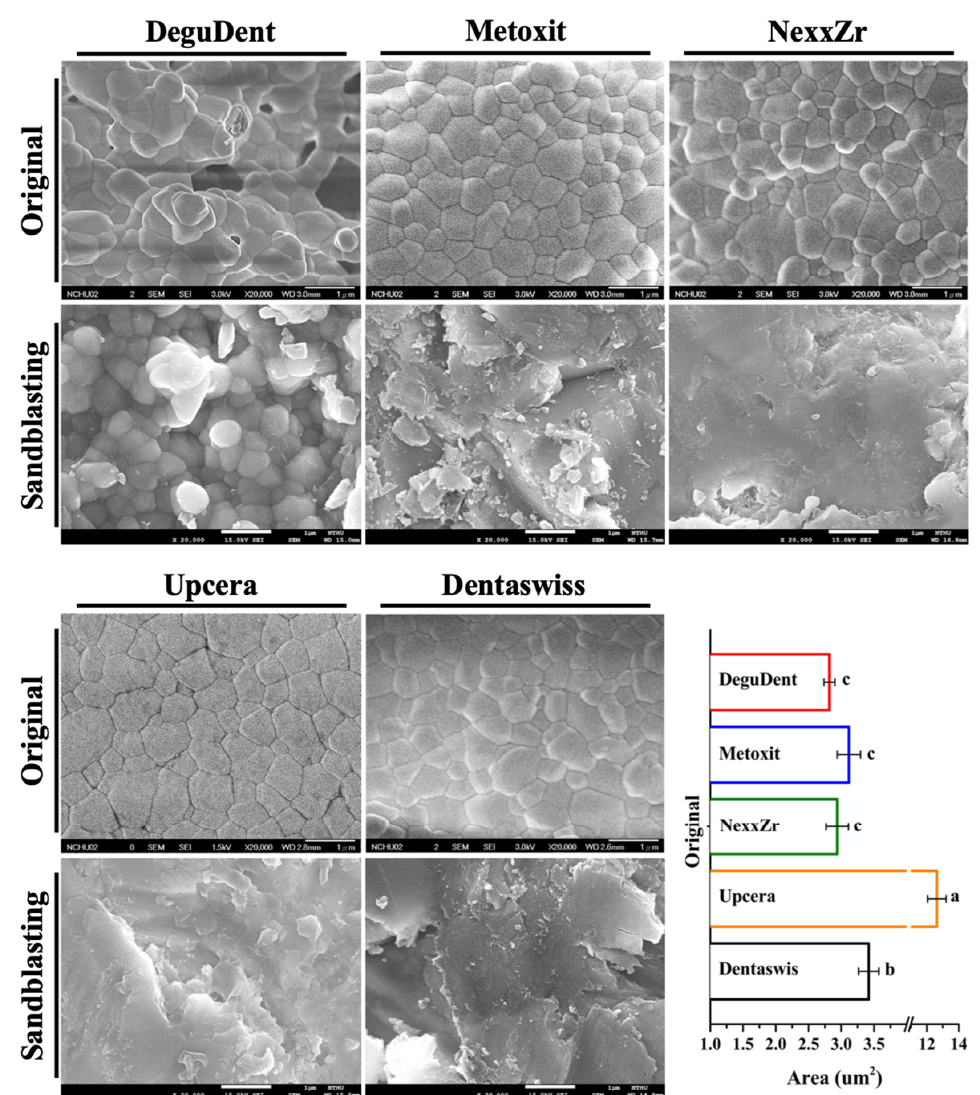
Figure 3. The surface morphology of zirconia before and after sandblasting. Means with different letters were significantly different ( p < 0.05, mean ± SD, n = 4).